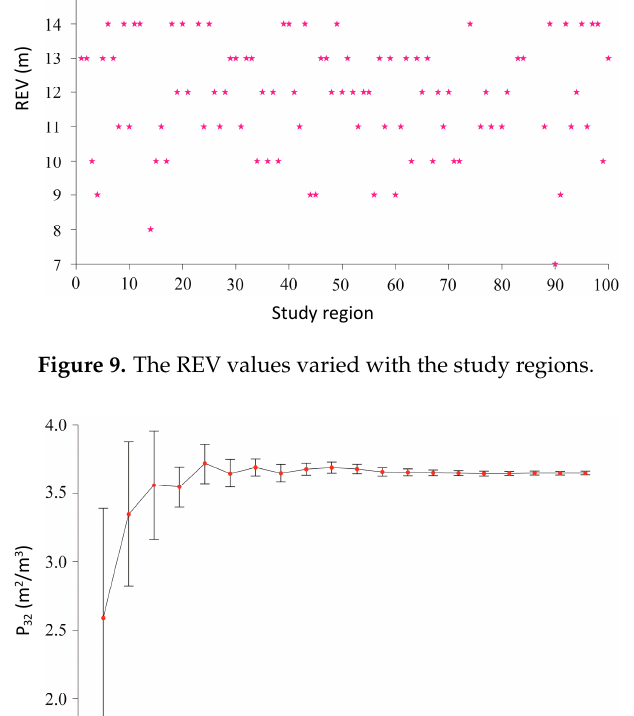
Figure 9. The REV values varied with the study regions. Figure 10. The error bar chart with confidence interval for different